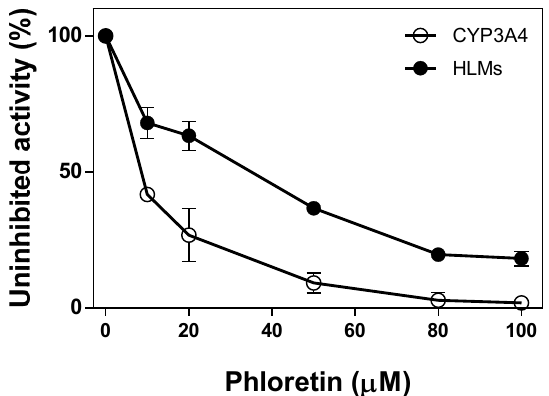
Figure 6. Phloretin’s inhibitory effect on the testosterone 6 β‐ hydroxylation by CYP3A4 and HLMs. After preincubating phloretin with CYP3A4 ( ○ ) and HLMs ( ● ) in the presence of NADPH for 5 min, testosterone (0.50 mM) was added to start the reaction. The reactions were terminated after 30 min. The formation of 6 β‐ OH testosterone was measured by HPLC. Values represent the means ± SD of three determinations.